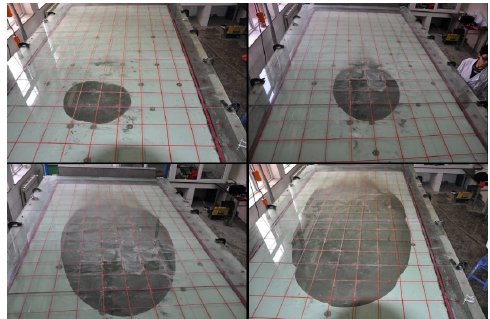
Figure 5. Grouting diffusion traces at a representative time (type 1).